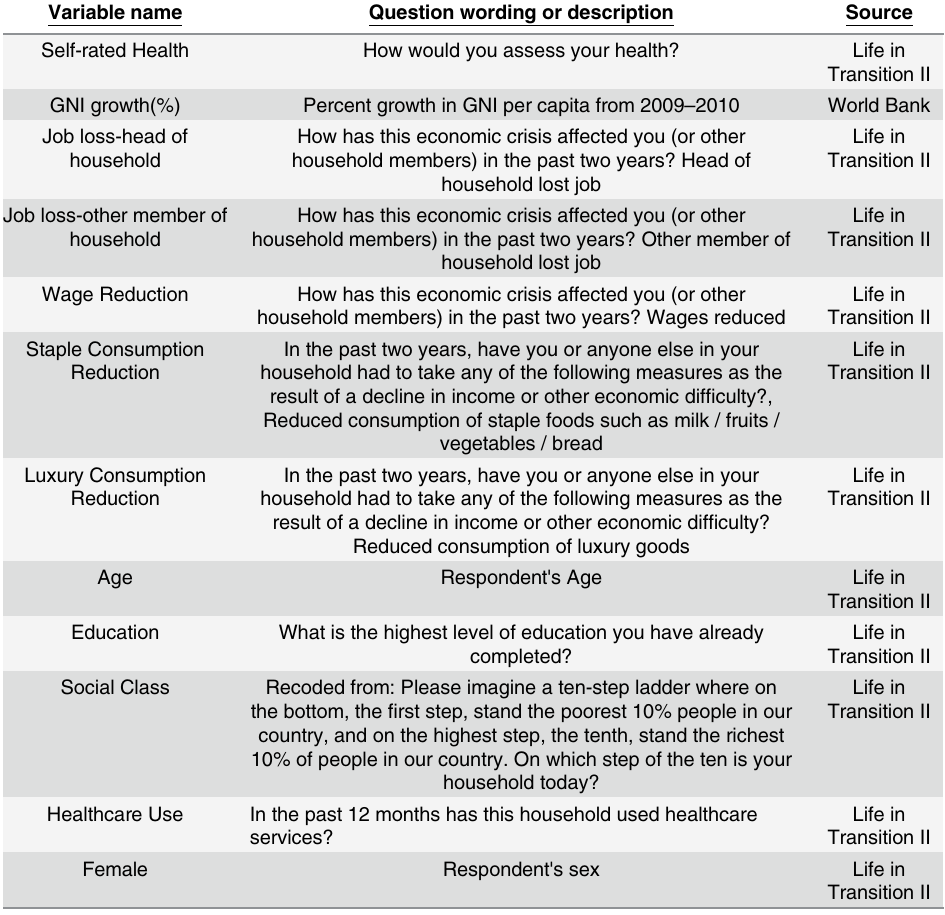
Table 1. Question Wordings and Descriptions for Self-Rated Health and Recession Experience